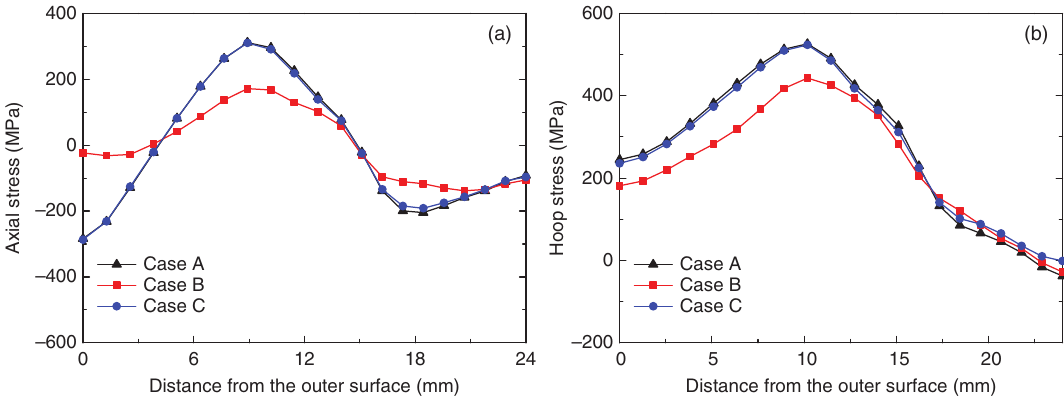
Figure 11: Residual stresses distributions at different welding sequences along path 2: axial stress (a), hoop stress